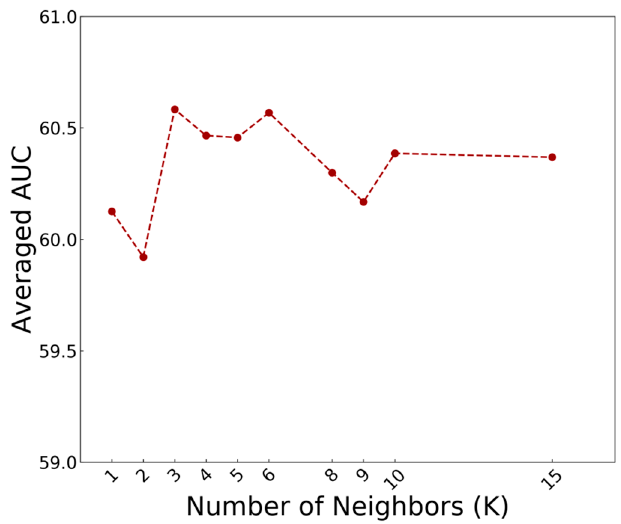
Figure 13. Classification results using different values for In-painting KNN-Imputation.